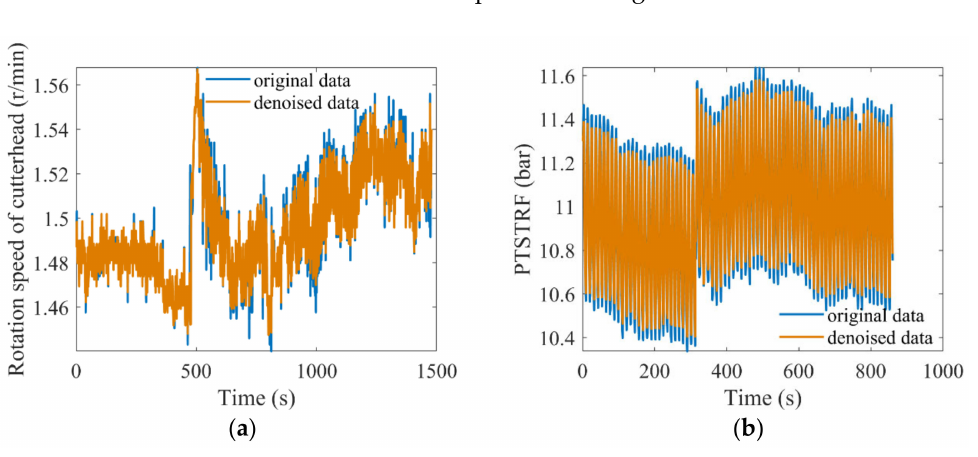
Figure 8. Denoising results of proposed method: ( a ) rotation speed of cutterhead and ( b ) pressure of tail skin system at top right